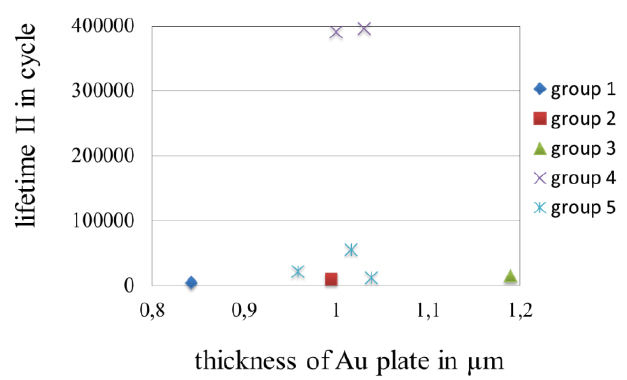
Figure 25. The lifetime and the thickness of gold platings.